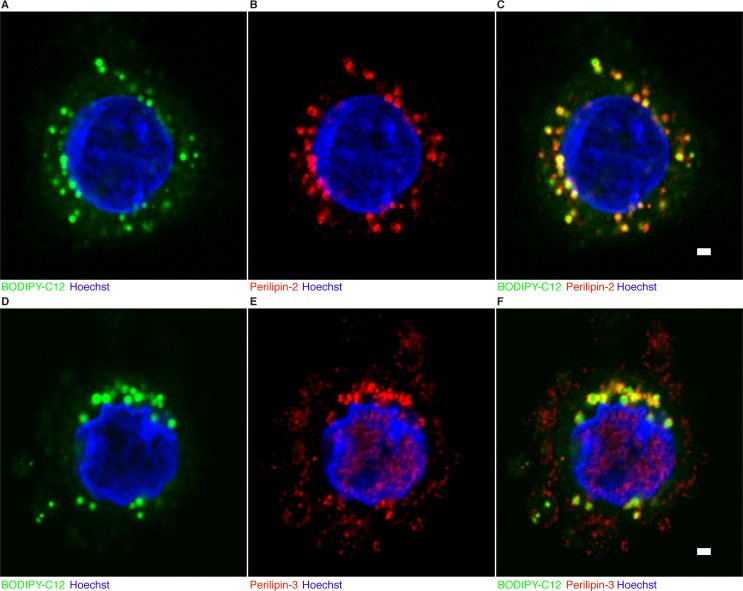
BODIPY-C12 incorporates into Perilipin-2 and Perilipin-3 labeled cytotrophoblast lipid droplets.Cytotrophoblast plated for 4hr onto glass coverslips were incubated with 2μM BODIPY-C12 for 30 minutes and fixed as described in the methods section. Cells were immunolabeled with Perilipin-2 or Perilipin-3. Nuclei are labeled using Hoechst dye. All BODIPY-C12 cytotrophoblast lipid droplets contain some degree of Perilipin-2 (A-C) or Perilipin-3 (D-F) on the surface. In addition to the presence of Perilipin-3 on lipid droplets, Perilipin-3 is also distributed on the plasma membrane of cytotrophoblast (E). n = 5. Scale Bar: 1μm.